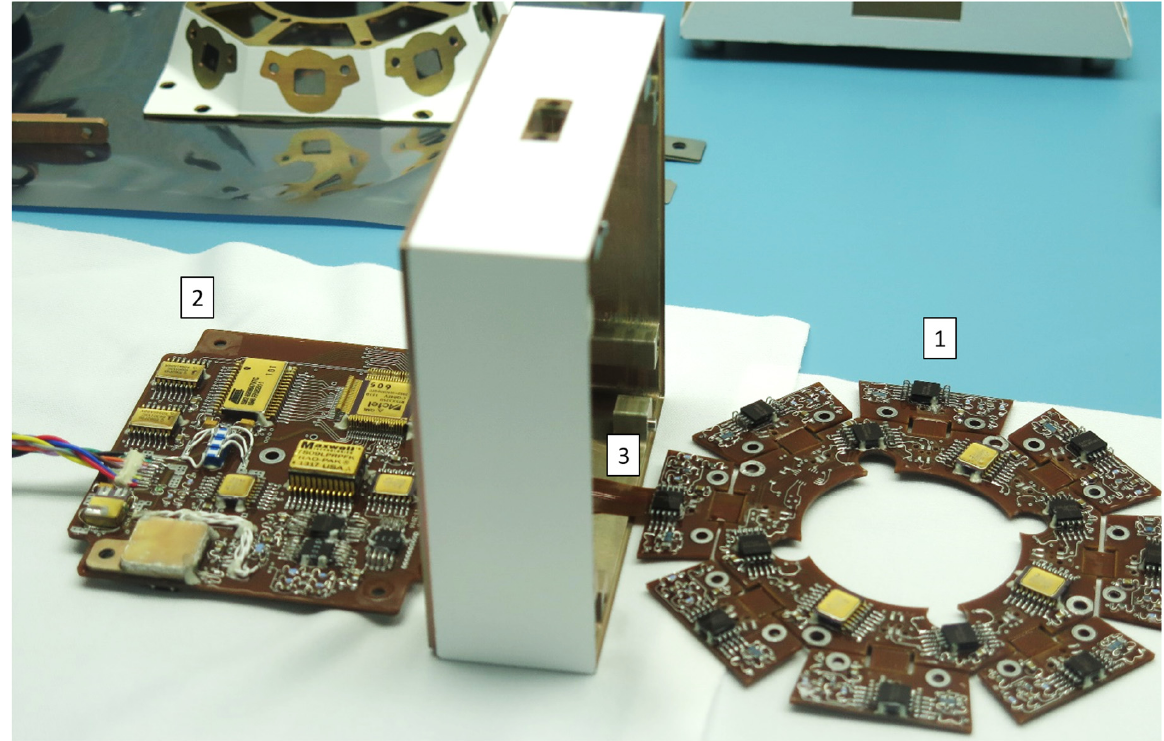
Figure 6. First step of the RDS integration process. It can be seen the RDS-DP optical head (1) PCB, the processing electronics PCB (2) and the flex cable (3) that links both.